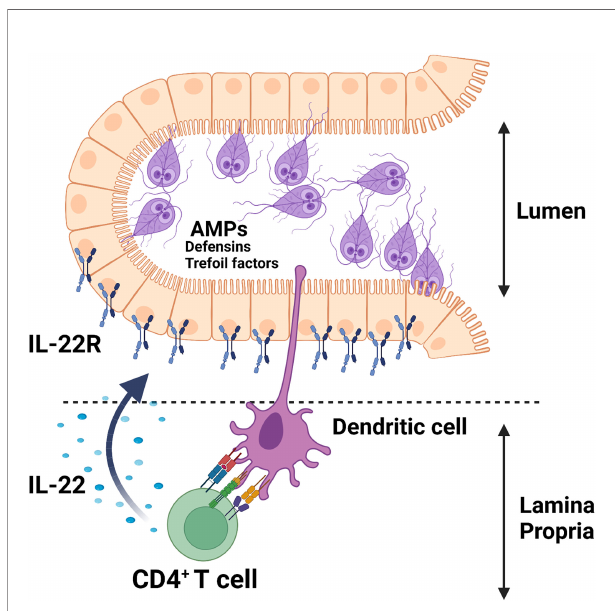
FIGURE 1 | Giardia infection induces the secretion of AMPs (e.g.,defensins, trefoilfactors)in parasitized IECs likely via an IL-22/IL-22R-mediated